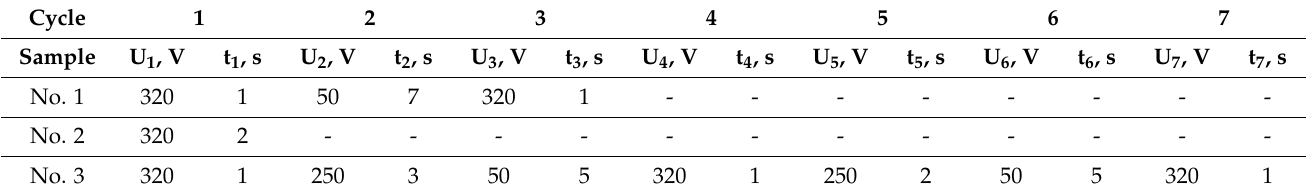
Figure 1. ( a ) Electrolyte plasma sample treatment process; ( b ) functional diagram: 1—workpiece; 2—cone-shaped stainless steel electrolytic cell; 3—sump; 4—pump; 5—heat exchanger; 6—electrolyte bath. Table 1. Technological parameters of electrolytic plasma thermal cycling treatment modes for 40 Kh steel.